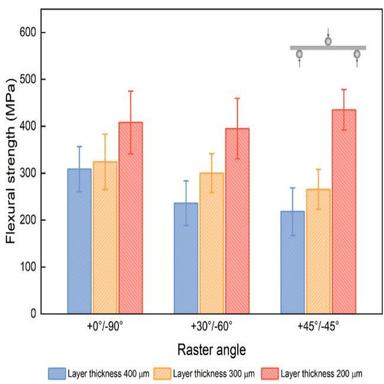
Comparison of flexural strength of 3D printed zirconia when printed at different layer thicknesses and raster angles.